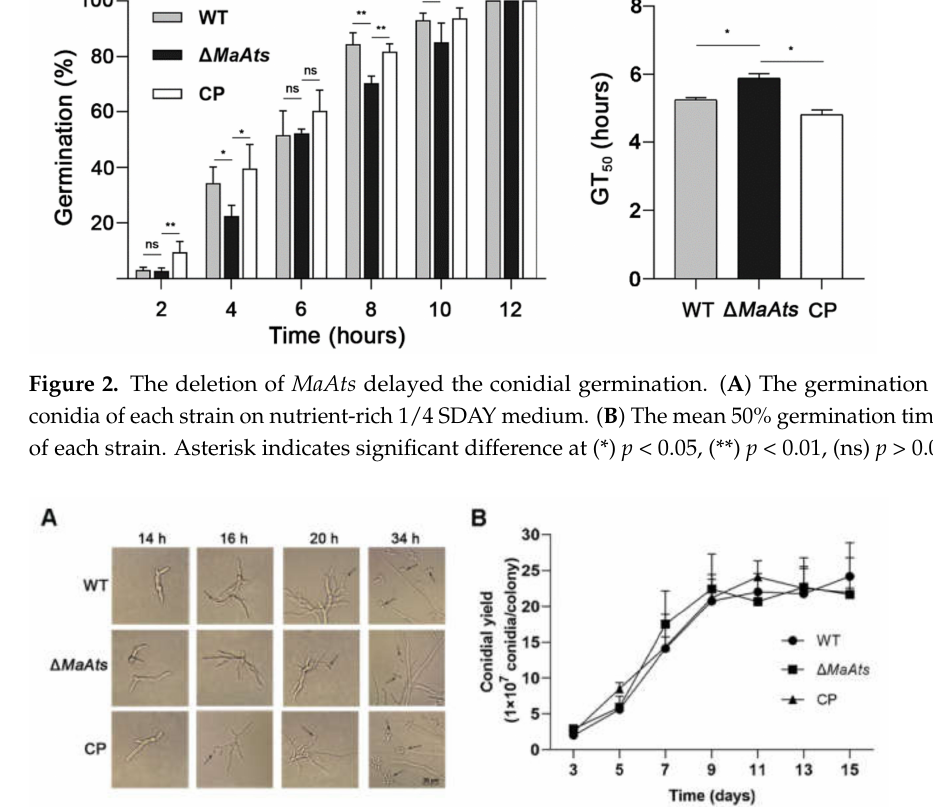
Figure 3. The deletion of MaAts delayed conidiation. ( A ) Conidiation of each strain cultured on nutrient-rich 1/4 SDAY medium. Black arrows indicate the typical conidiophores and conidia. ( B ) Conidial yield of WT, ∆ MaAts and CP strains on nutrient-rich 1/4 SDAY medium at 28 ◦